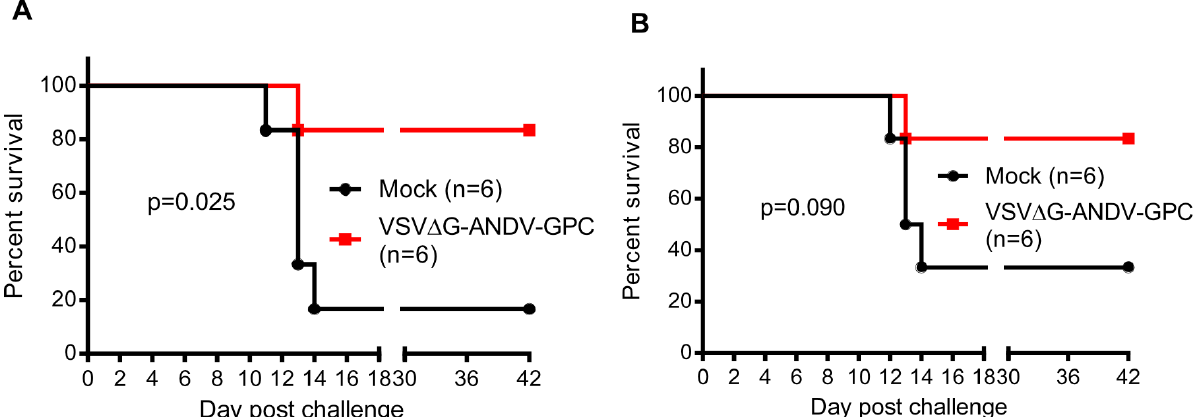
Figure 1. A single dose of a vesicular stomatitis virus (VSV)-based Andes virus (ANDV) vaccine affords significant protection from ANDV disease at 6 months, but not 12 months post-vaccination. Groups of 12 animals were either mock-vaccinated or vaccinated with 10 5 PFU of VSV ∆ G-ANDV-GPC i.m., and six animals per group were challenged with 200 focus forming units (FFU) of ANDV i.n. 6 months ( A ) or 12 months ( B ) after vaccination. Animals were monitored for clinical signs of disease and survival for 42